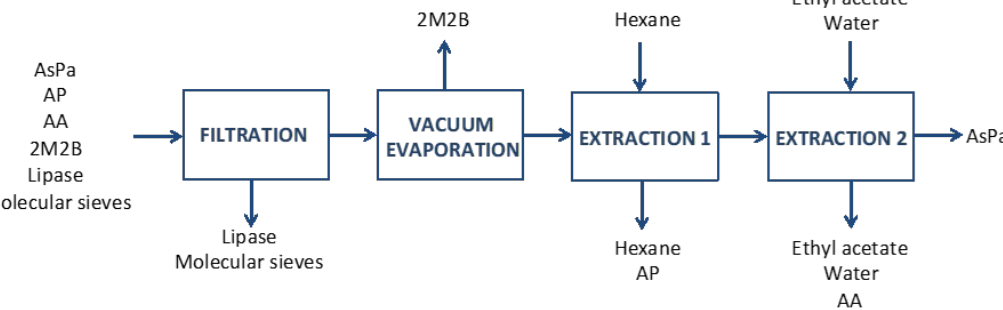
Figure 4. Schematic representation of the downstream process of ascorbyl palmitate synthesis.